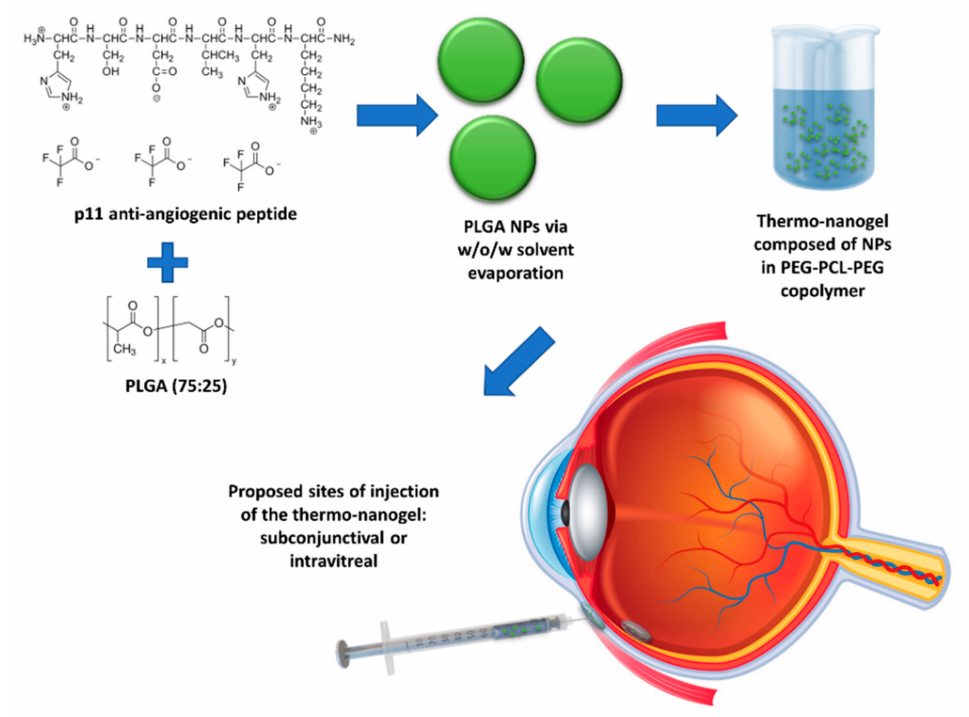
Figure 1. Schematic depiction of the componential formulation and proposed delivery of the thermo- nanogel